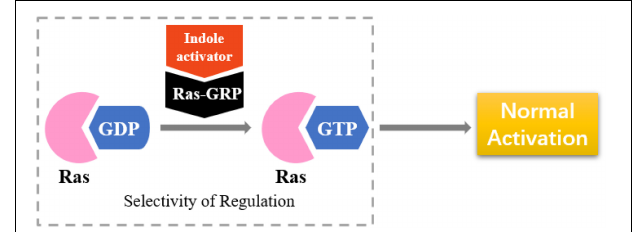
FIGURE 8 | Selectivity of regulation by indole derivatives.